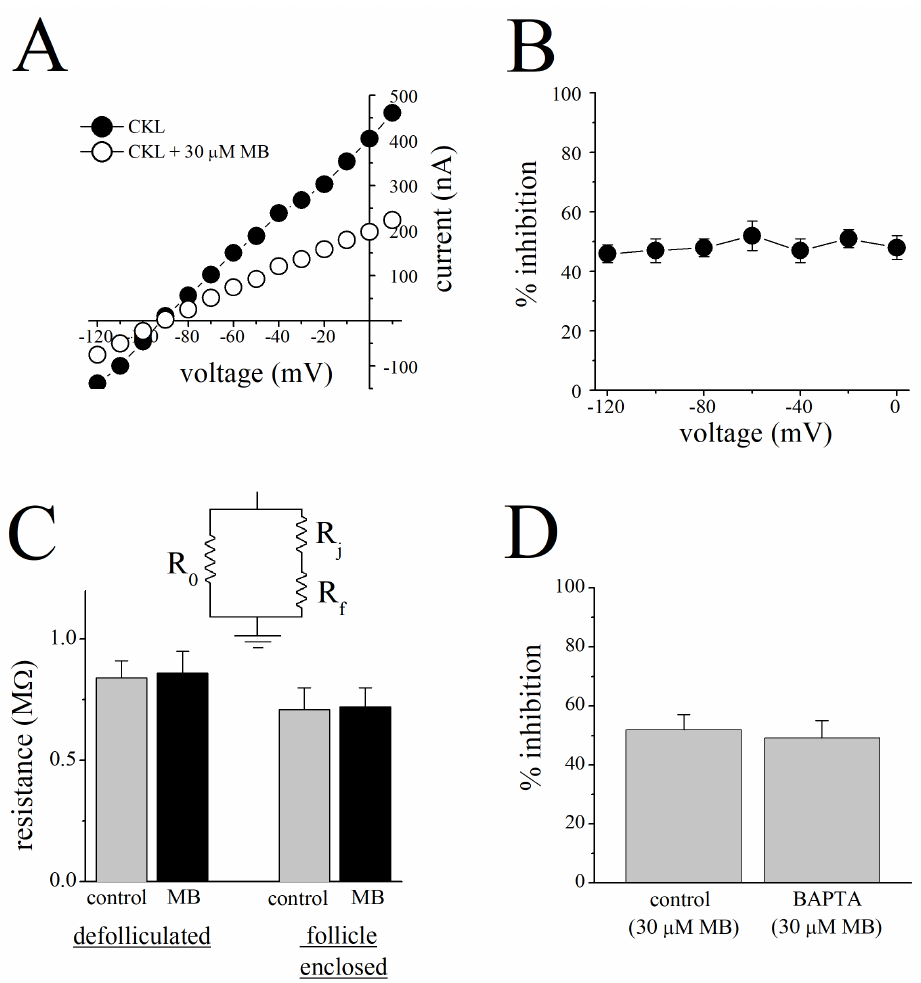
Figure 2. Inhibition of cromakalim-induced K + currents by MB is voltage-independent and not mediated through gap junctions. ( A ) Current-voltage relationship of cromakalim-activated currents recorded during 1 s voltage steps applied before ( filled circles ) and after application of 30 µ M MB ( open circles ). ( B ) Different membrane potentials did not alter percentage inhibition of cromakalim- activated K + currents by MB. Differences among the means of current inhibitions by 30 µ M MB at different holding potentials were not statistically significant ( p > 0.05, ANOVA, n = 5–7). ( C ) Inset to Figure 2C indicates the equivalent resistive-circuit diagram. The mean values for the sum of resistances through the oocyte gap junction (R j ), follicular cell membranes (R f ) in follicle-enclosed oocytes before ( gray bars ) and after 20 min administration of 30 µ M MB ( black bars) are shown on the right side ( n = 14). Membrane resistance (R o ) of enzymatically defolliculated oocytes before and after MB treatment are presented on the left ( n = 16). Values of resistances were calculated from current-voltage curves recorded in the range between –50 mV and +10 mV. ( D ) Effect of MB (30 µ M) on cromakalim (100 µ M)-induced K + currents in control and in BAPTA-pretreated oocytes. CKL: cromakalim; MB: methylene